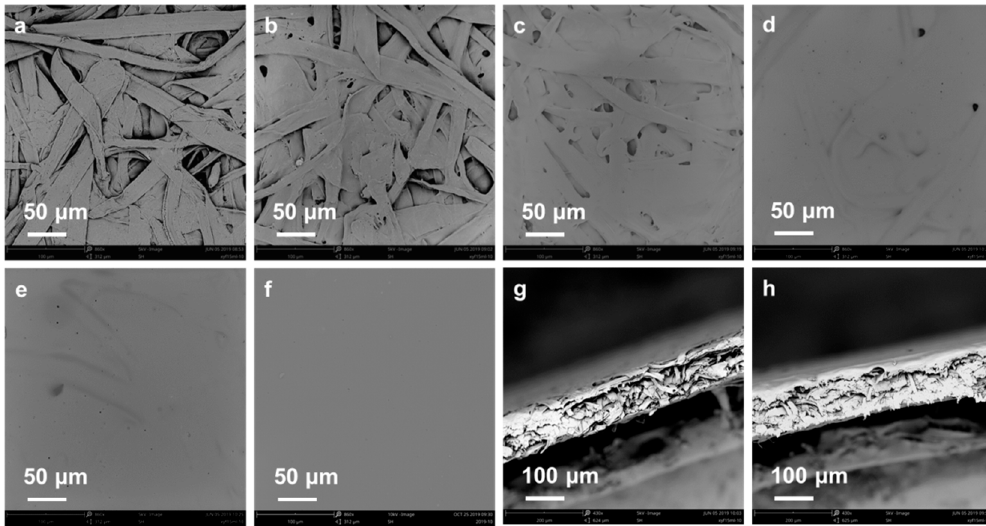
Figure 4. SEM surface images of unmodified paper ( a ), CUE 0.97 -coated paper ( b ), CUE 2.47 -coated paper ( c ), CUE 6.25 -coated paper ( d ), CUE 11.62 -coated paper ( e ), and CUE 21.38 -coated paper ( f ); and SEM cross-section images of unmodified paper ( g ) and CUE 11.62 -coated paper ( h ).